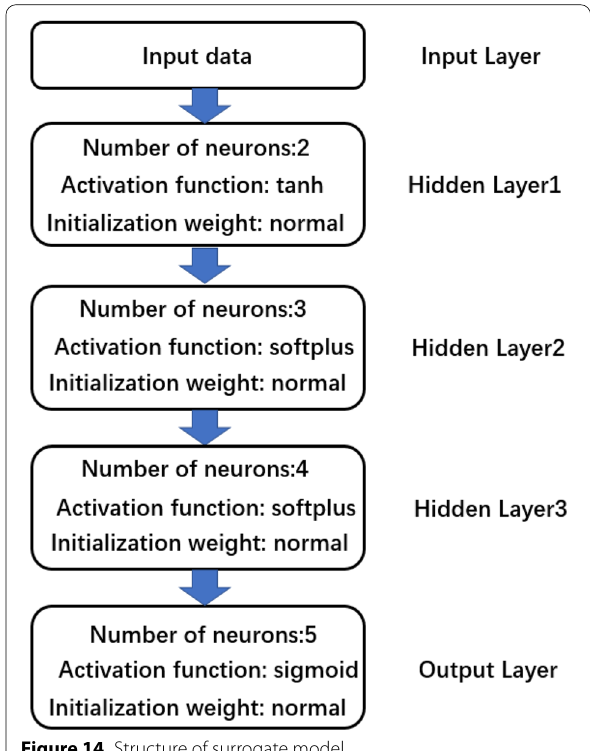
Figure 14 Structure of surrogate model